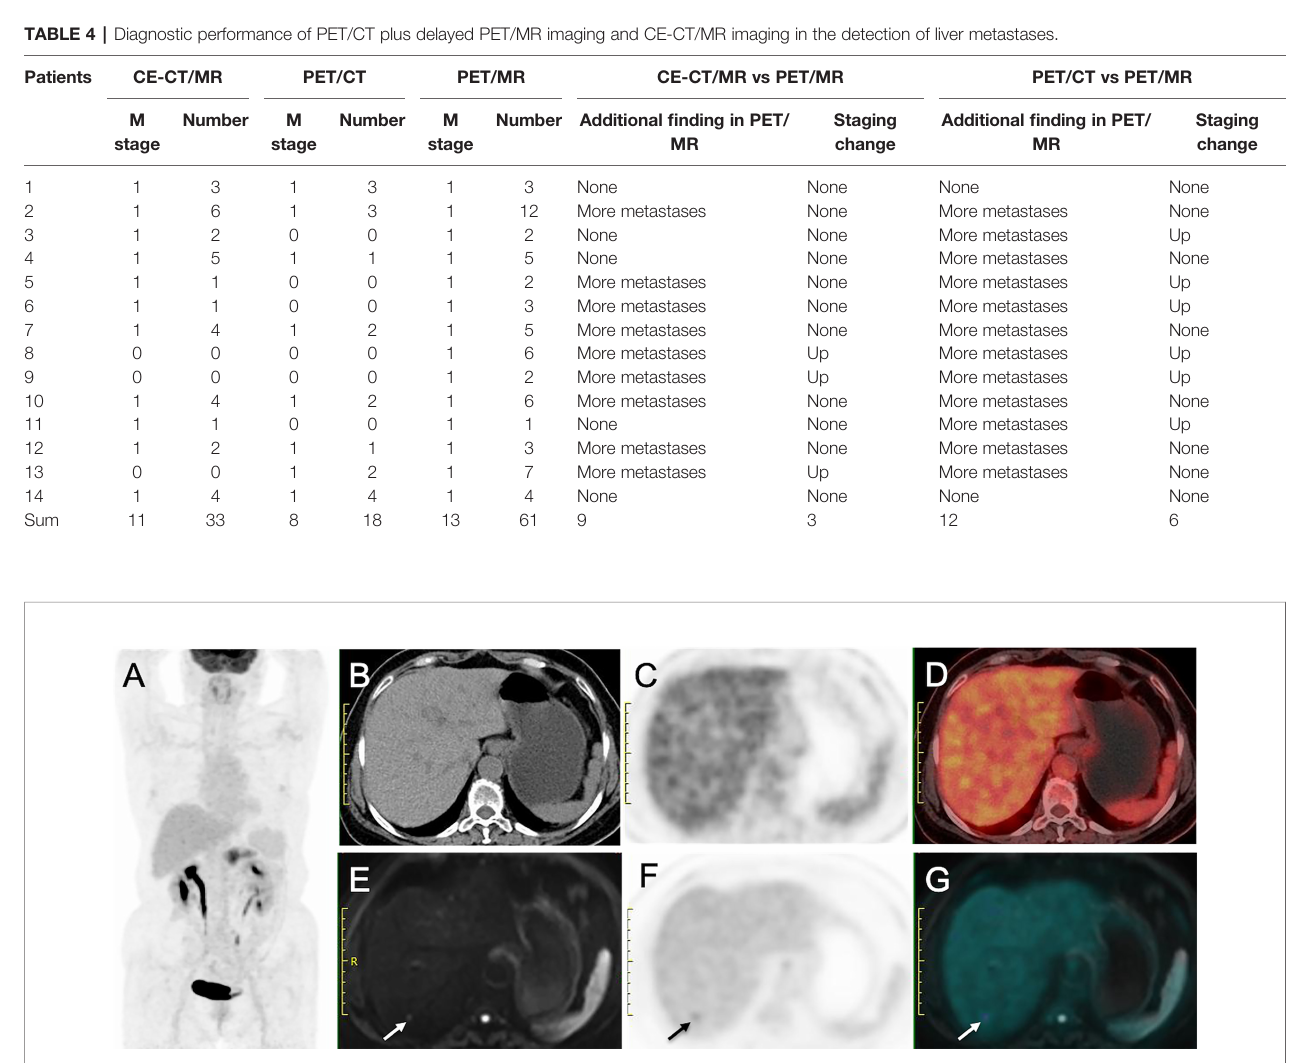
FIGURE 3 | Liver metastasis detected on PET/MRI but not on PET/CT. (A) MIP from PET/CT showing increased uptake in pancreas. (B) Nonenhanced CT image, (C) Early PET image and (D) PET/CT fusion image show no hypoattenuating or hypermetabolic lesion in liver. (E) DW image (b = 800 sec/mm2) shows a nodule with restricted diffusion (arrow). (F) Delayed PET image shows a hypermetabolic lesion in liver. (G) Corresponding PET/MR imaging fusion image shows the nodule with both hyperintense and hypermetabolism. This patient was diagnosed as having stage M1 disease on PET/MR imaging but stage M0 disease on PET/CT.